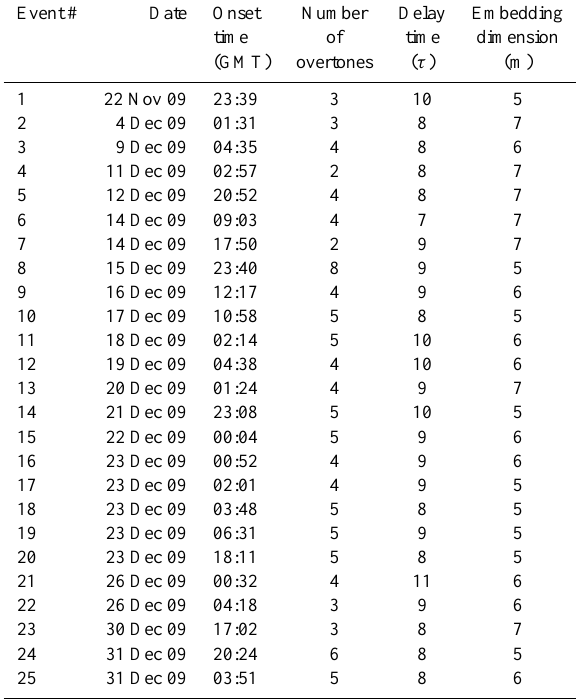
Table 1. Estimated delay time ( τ ) and embedding dimension ( m ) for each of the 25 volcanic tremor episodes under study.